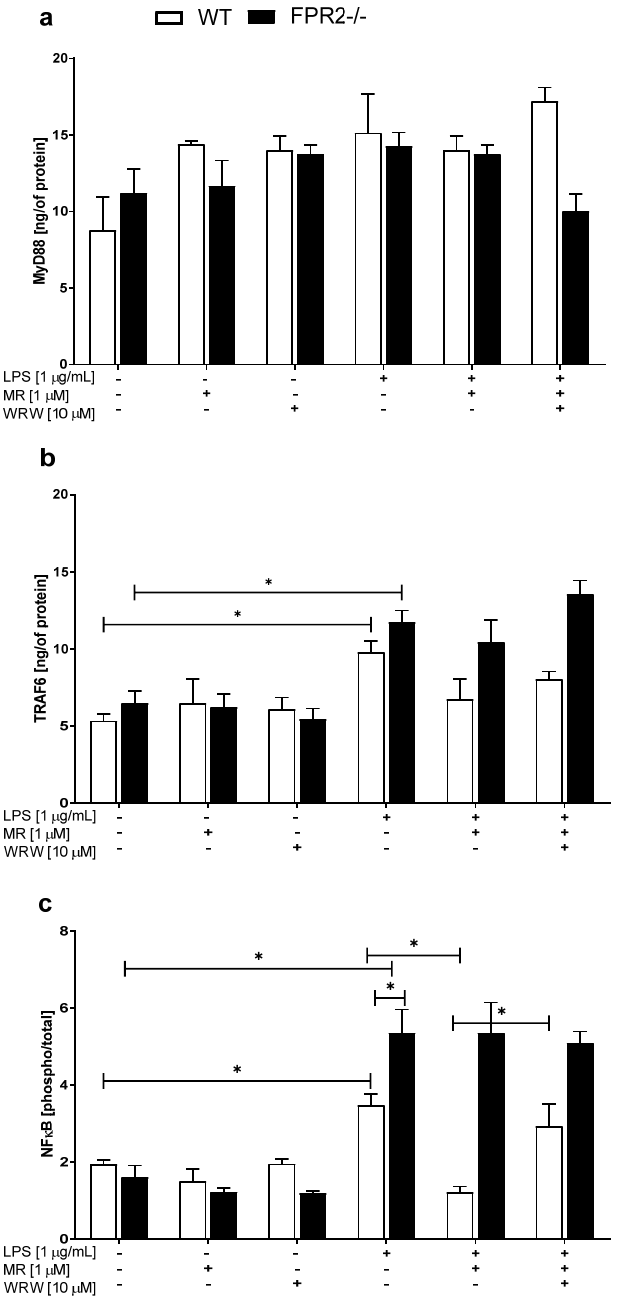
Figure 5. The effects of lipopolysaccharide and/or MR-39 and WRW4 on the ( a ) MyD88/ ( b ) TRAF6/( c ) NF κ B-related pathways in organotypic hippocampal cultures (OHCs) derived from the offspring of wild-type (WT) and FPR2 − / − (KO) mice. OHCs obtained from WT and KO mice were pretreated with the FPR2 antagonist WRW4 (10 µ M) for 30 min. Afterward, MR-39 (1 µ M) was added and incubated for 1 h, and then OHCs were stimulated with lipopolysaccharide (LPS; 1 µ g/mL) for 24 h. Control cultures were treated with the appropriate vehicle. The results are presented as the means ± SEM. The data were obtained from three independent experiments. The results were statistically evaluated using a factorial analysis of variance (ANOVA) with Duncan’s post hoc test to assess the differences between the treatment groups. Significant differences are indicated by * p < 0.05. TRAF6—TNF receptor-associated factor 6; MyD88—Myeloid differentiation primary response 88; NF κ B—Nuclear factor- κ B. +—with LPS, MR or WRW treatment; —-without LPS, MR or WRW